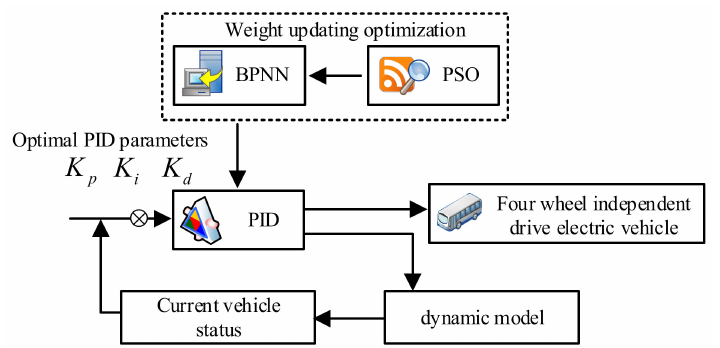
Figure 2. Operation flow of neural network PID